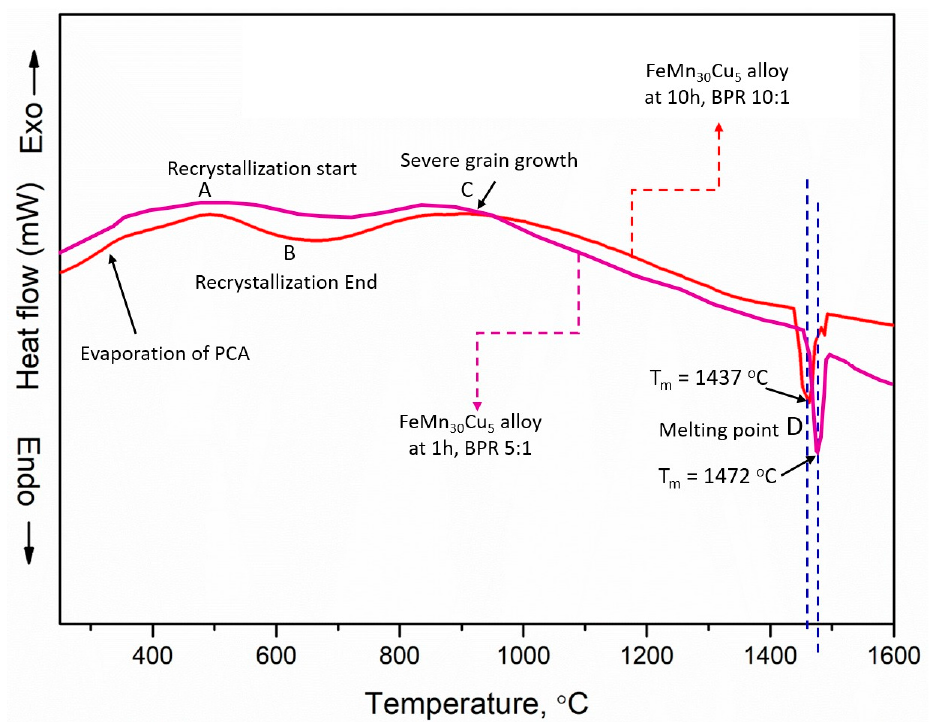
Figure 2. DSC curves of FeMn 30 Cu 5 for two different milling condition (milling times: 1 and 10 h; BPRs: 5:1 and 10:1) .